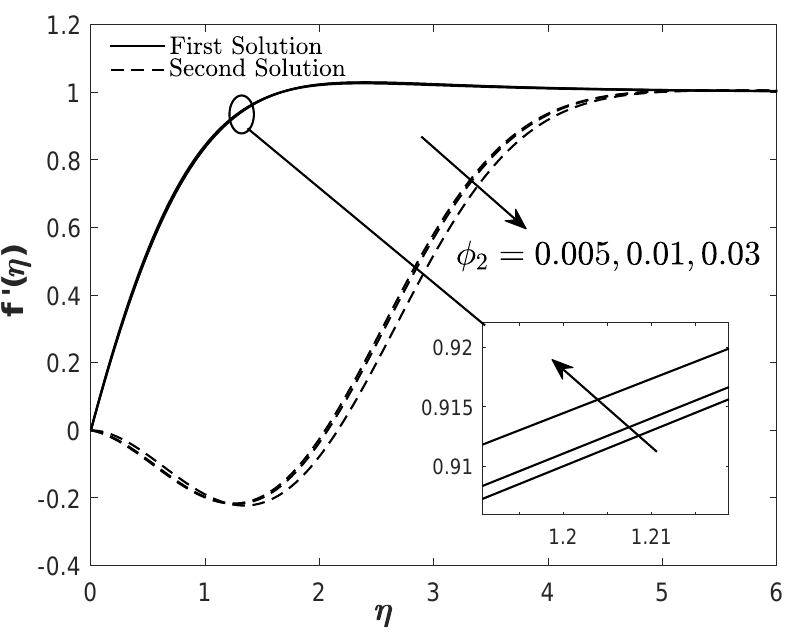
Figure 9. Velocity profile for various values of φ 2